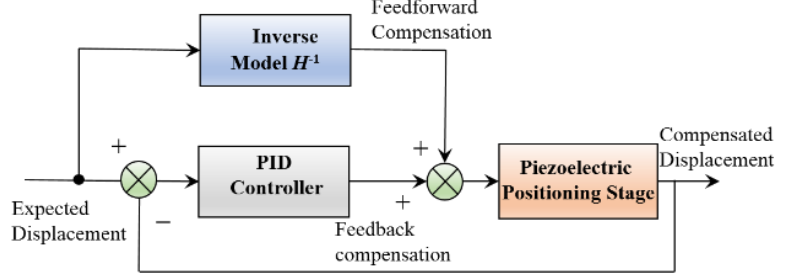
Figure 12. Scheme of hysteresis compound compensation.